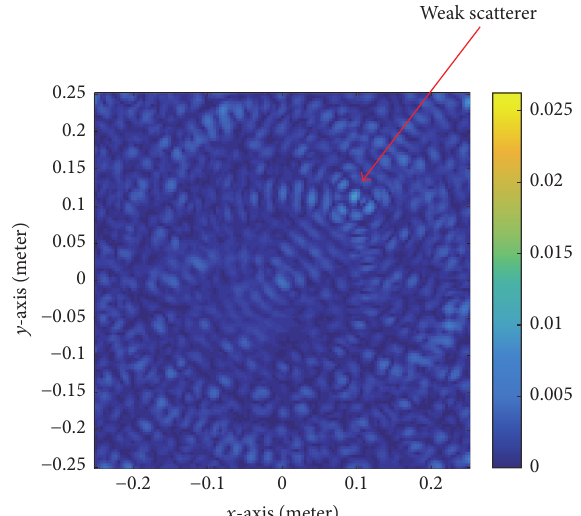
Figure 16: The results of applying CLEAN algorithm for irregular complex shape geometry.